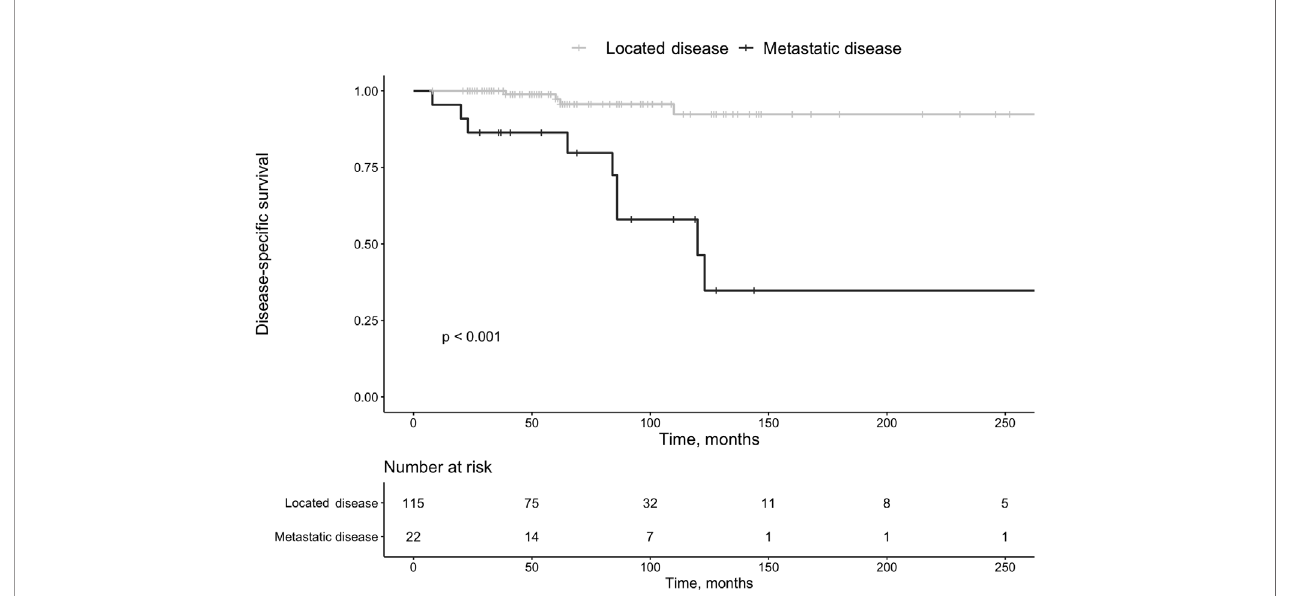
FIGURE 4 | Survival in patients with pan-NETs with localized disease at diagnosis vs. those with metastatic disease at that time